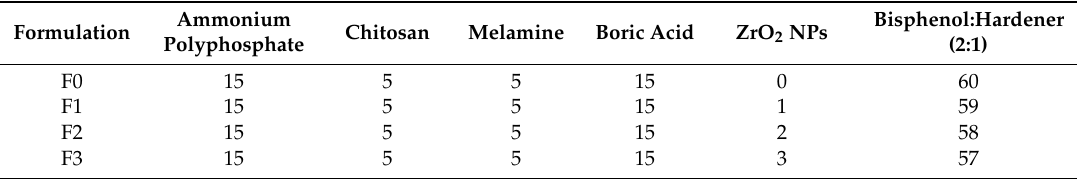
Table 1. The ratio of formulation epoxy resin nanocomposites in w / w